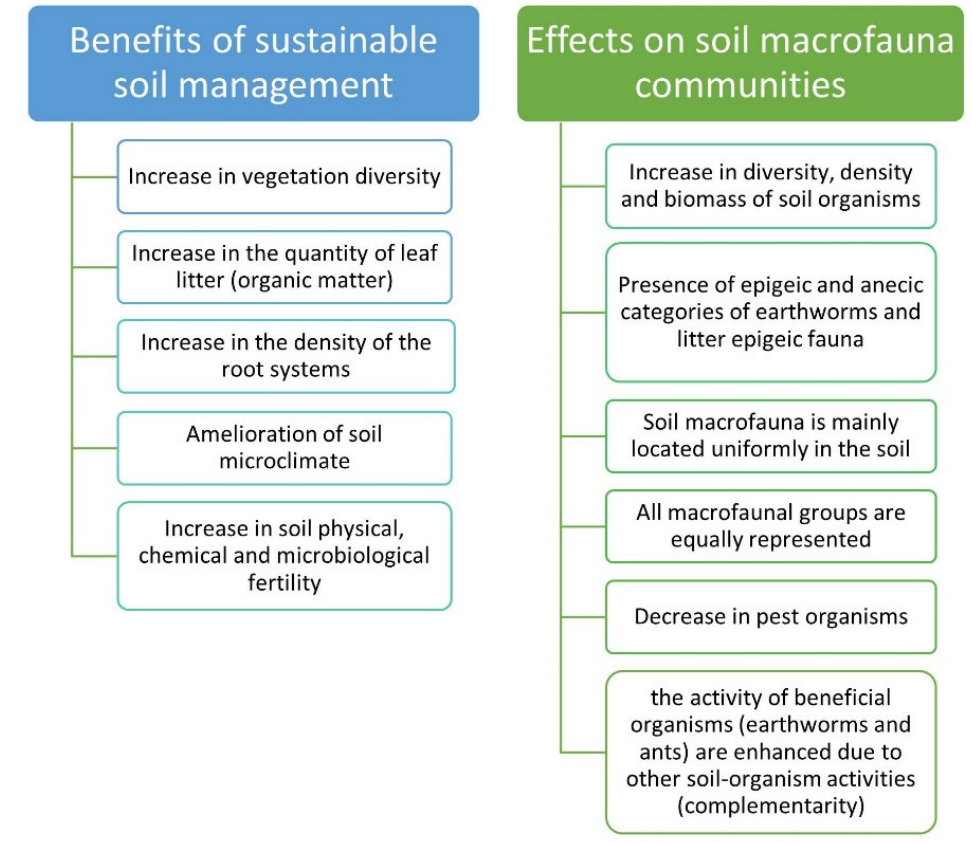
Figure 3. Benefits of sustainable soil management and its effect on soil macrofauna.